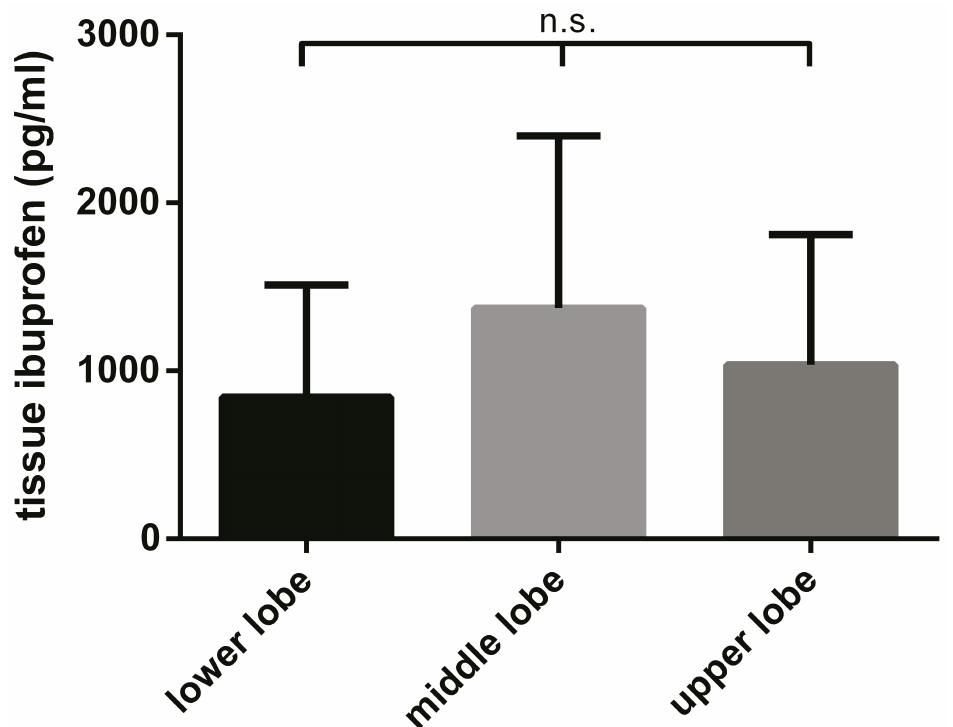
Figure 1. Ibuprofen concentration in the dependent parts of the three lobes of the right lung (mean ± SD for n = 24). The highest ibuprofen concentration was detected in the middle lobe, but no significant differences were observed between the three locations, indicating equal distributions throughout the lung